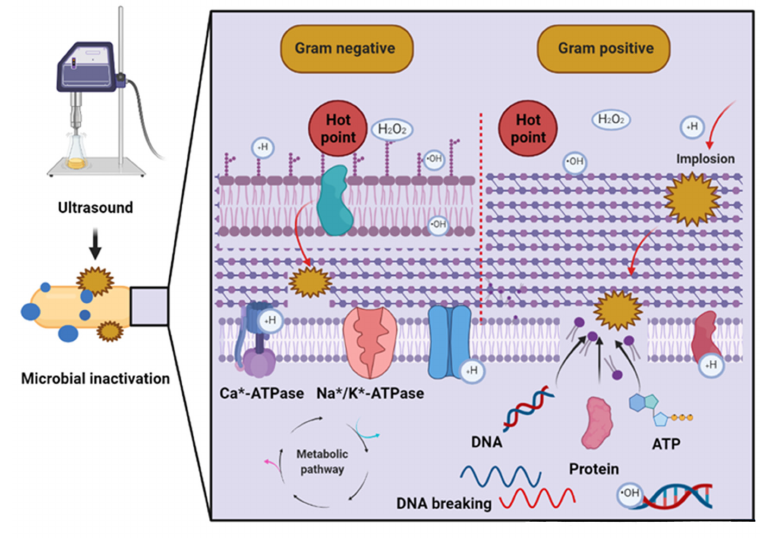
Figure 1. Mechanisms of microbial inactivation by ultrasound [51,54] (Created with BioRender.com; accessed on 30 March 2022). DNA: Deoxyribonucleic acid, ATP: Adenosine